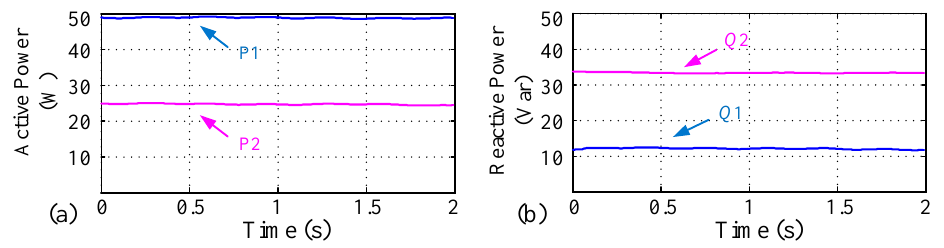
Figure 20. Steady-state power of Case II: ( a ) active power; and ( b ) reactive power.